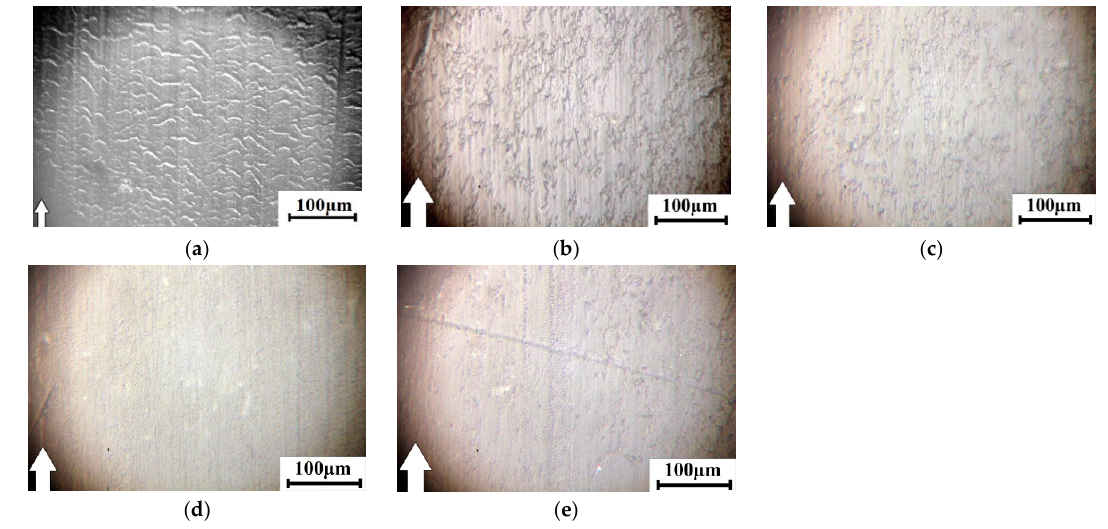
Figure 13. Optical images of the wear track surfaces of neat UHMWPE ( a ); and the “UHMWPE + 23 wt. % wollastonite” composites: without silane coupling agent ( b ); “KH-550” ( c ); “Penta-1006” ( d ); and “OTS” ( e ) (Load = 140 N, Velocity = 0.5 m ∙ s − 1 )